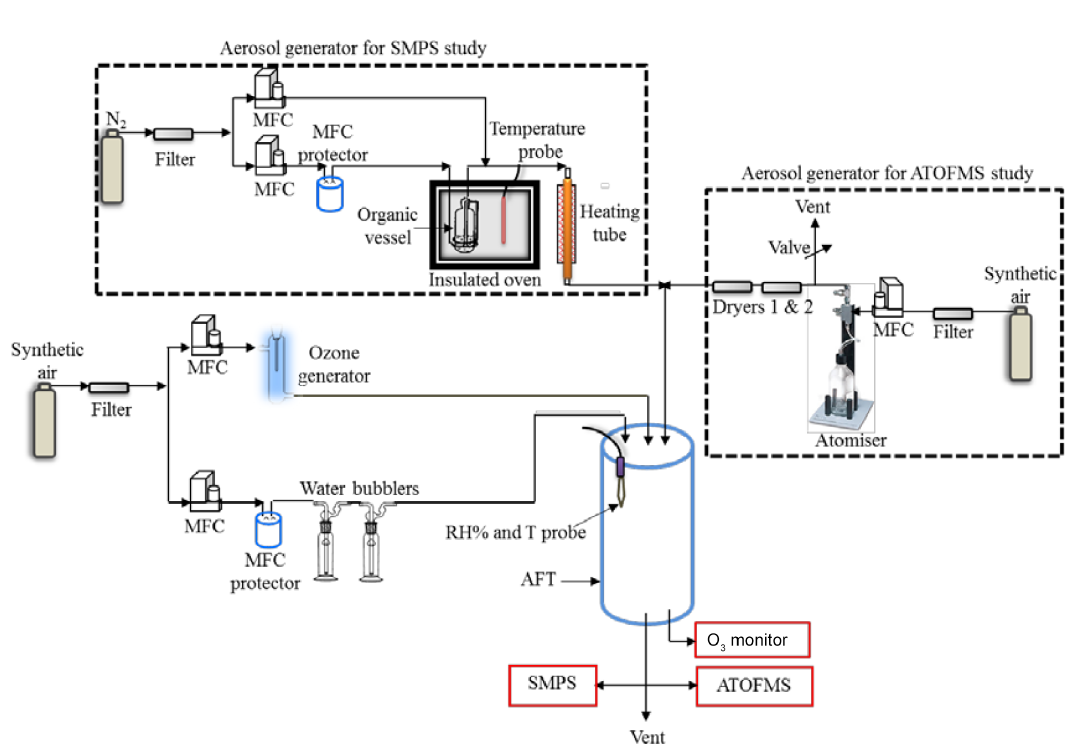
Figure 1. The experimental set-up for the study of the heterogeneous oxidation of OL aerosol.